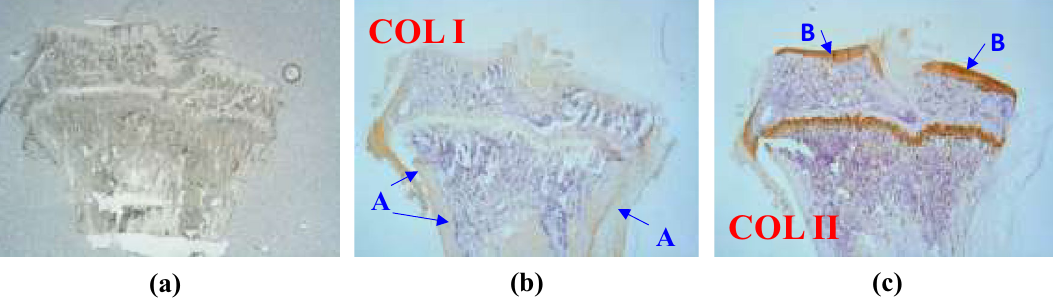
Figure 1. Coronal section of tibia bone: ( a ) bright field image, ( b ) histological image stained for type I collagen (COL I), and ( c ) histological image stained for type II collagen (COL II). Zone A corresponds to cortical bone section rich in collagen type I (brown or brownish-yellow). Zone B corresponds to articular cartilage section rich in collagen type II (dark brown or